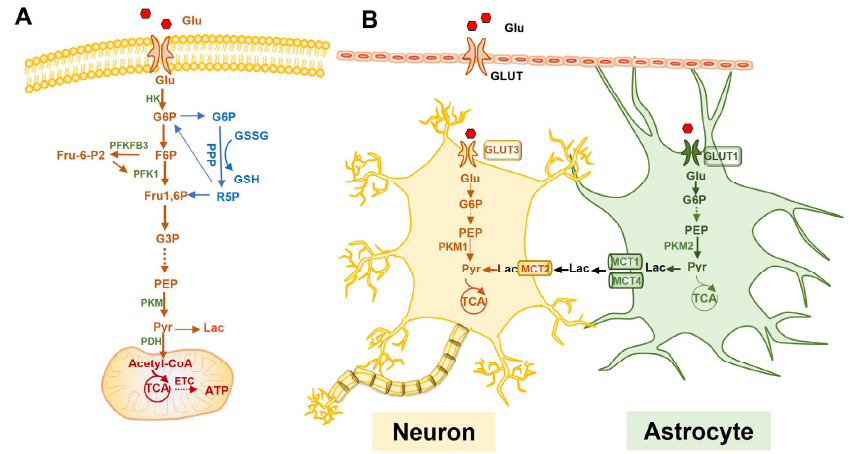
Figure 2. Glucose metabolism and the astrocyte-neuron lactate shuttle (ANLS) hypothesis. ( A ): The metabolic pathway of glucose in neural cells. ( B ): The ANLS hypothesis. Glucose enters astrocytes via GLUT1, which transports to neurons via GLUT3. Astrocytes usually perform aerobic glycolysis to convert glucose to lactate, which is exported outside the cell via monocarboxylate transporter protein 1 or 4 (MCT1/4) and transported to neurons via MCT2. Lactate is then converted to pyruvate in neurons, which is used to promote OXPHOS in the mitochondria. Glu, glucose; GLUT, glucose transporter; G6P, glucose-6-phosphate; F6P, fructose-6-phosphate; Fru1,6P, fructose 1,6-bisphosphate; HK, hexokinase; PFKFB3, phosphofructokinase-2/fructose-2,6-bisphosphatase 3; F-2,6-P, fructose-2,6- diphosphate; PFK1, fructose-phosphate kinase-1; PPP, pentose phosphorylation; TCA, tricarboxylic acid cycle; NADPH, nicotinamide adenine dinucleotide phosphate; PKM1, pyruvate kinase 1; PKM2, pyruvate kinase 2; PDK4, pyruvate dehydrogenase 4; PDH, pyruvate dehydrogenase; Pyr, pyruvate; Lac, lactate; MCT, monocarboxylate transporter; ETC, electron transport